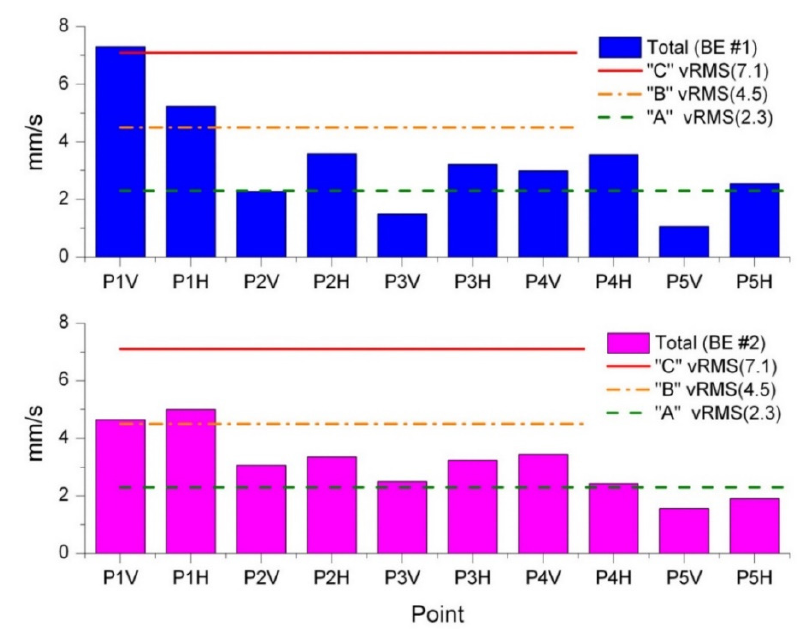
Figure 13. Comparison of the total values of the RMS velocity in points P1 to P5 of the tested drive units of elevators BE#1 ( top ) and BE#2 (bottom ).